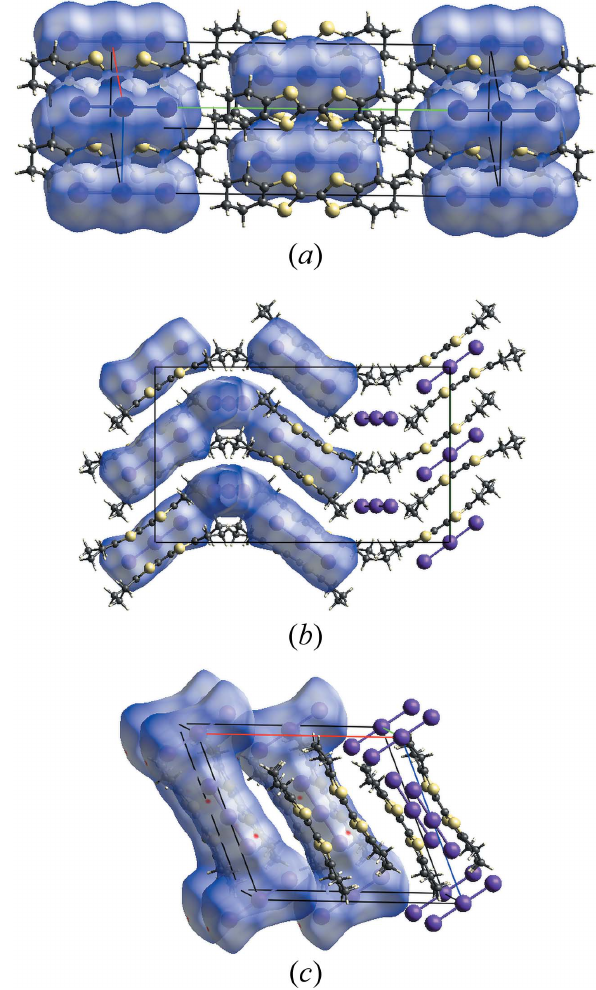
Figure 6 Sections of the crystal structures of the ( a ) (cid:4) , ( b ) (cid:5) and ( c ) (cid:6) polymorphs of (OMTTF (cid:4) + )(I 3 (cid:3) ). For details about the structures, please see: the Database survey section of this work and Konarev et al. (2005). For clarity, the I 3 (cid:3) units are drawn in different formats: either as Hirshfeld surface representations ( d norm ) or using ‘ball-and-stick’ models. The a axis is drawn in red, the b axis is drawn in green and the c axis in blue. The cell in ( b ) is viewed along the a